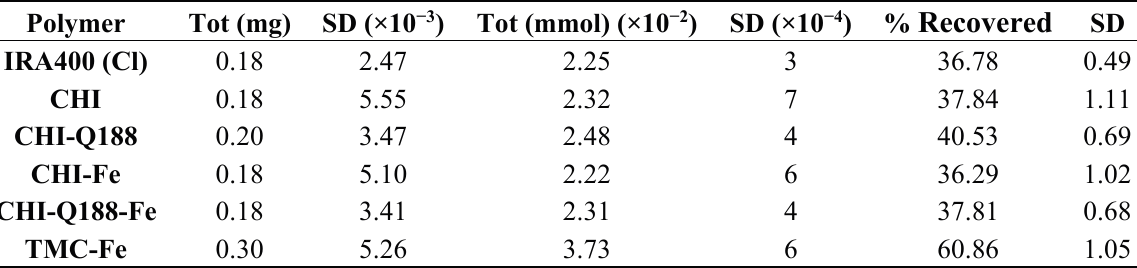
Table 2. ClO (cid:2872)(cid:2879) retention for the polymers tested.